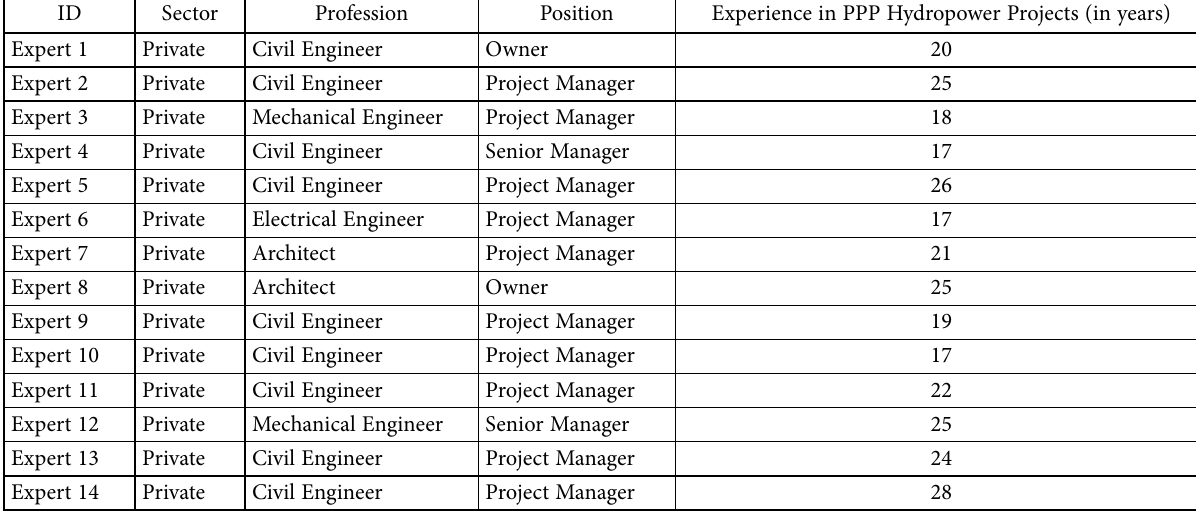
Table 1. Demographic information of